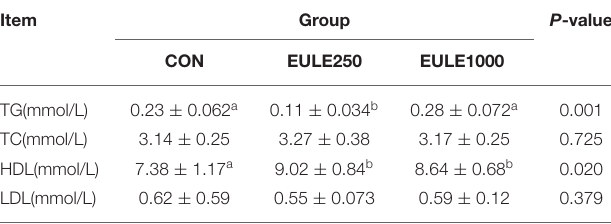
TABLE 3 | Effect of the EULEs on serum lipids in broilers.